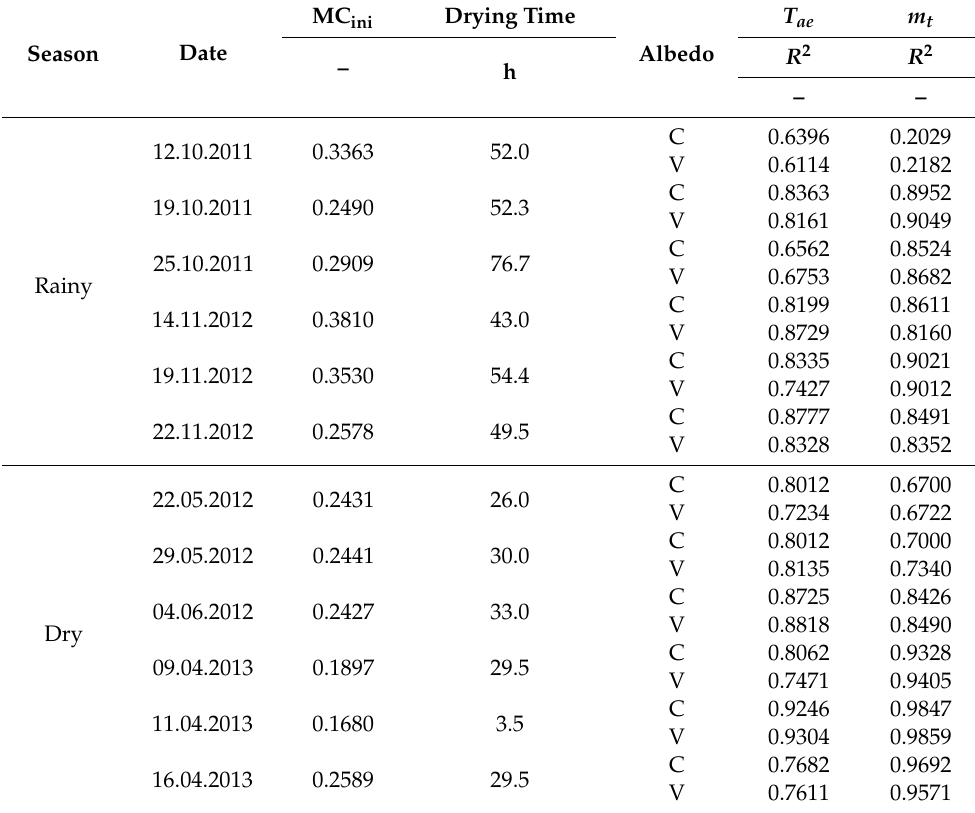
Table 3. Coe ffi cient of determination R 2 of air temperatures T ae and instantaneous mass m t at a constant albedo (C) of α pa = 0.1957 and variable (V) albedo α pa